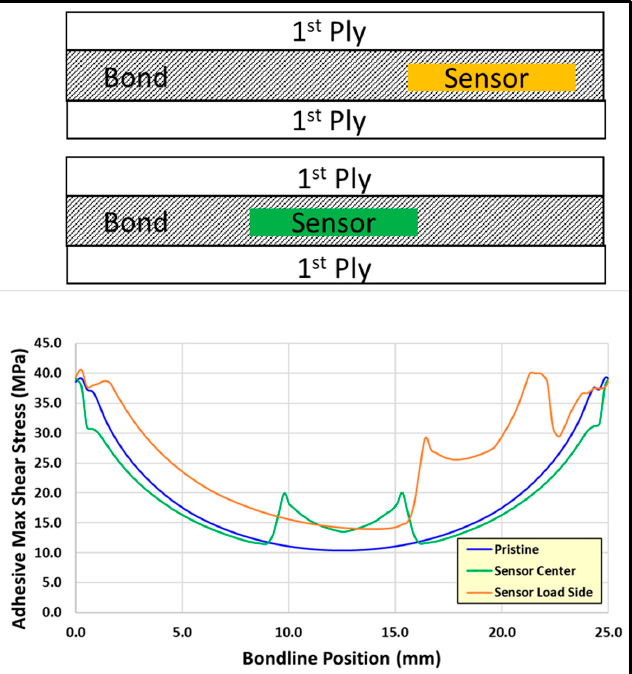
Figure 6. Analytical lap shear adhesive bond maximum shear stress distribution. For the pristine case, it is seen that the maximum shear stress through the bond thickness occurs at the endpoints of the bond area. There is about a 4:1 ratio between the center and endpoint maximum stresses. The analytical results further indicate that the shear bond performance degrades when the sensor is embedded in the area of maximum shear stress. There is a stress concentration at the edge of the bondline and adding the sensor to this location results in a higher imposed shear stress than the pristine case. Embedding the sensor at the center of the bond (the minimum stress position) results in a similar sen- sor effect on the stress distribution, but due to the location, the stress intensification at the sensor edges does not approach the stress seen in the pristine case at the bond endpoints. Based on these results, the bondline sensor locations for testing were selected to be the center position and the load end position. This covers the range of minimum to maximum sensor effect on the bondline shear stress distribution. 2.3. Adhesively Bonded Composite Single Lap Shear Coupon Fabrication Static shear testing was performed on single lap shear test coupons with, and with- out, embedded piezoelectric sensors in the bondline. The coupons were fabricated with composite adherends that consisted of 12 plies of T650-35/5320-1 carbon/epoxy 8HS wo- ven fabric prepreg in a quasi-isotropic layup ((45/0) 3 ) S . The laminates used the Solvay CY- COM 5320-1 toughened epoxy resin system and are vacuum-bag cured, out-of-autoclave, at 177 °C [26]. This resulted in an adherend thickness of 4.5 mm (0.376 mm thickness per cured ply). Figure 7 shows the layout of the adherends before the application of the adhe- sive.